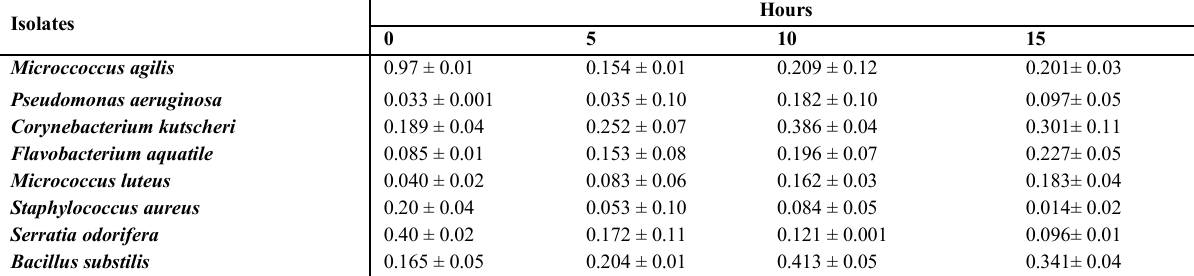
Table 7: Turbidity measurement of bacterial growth in hydrocarbon medium (OD600). Isolates